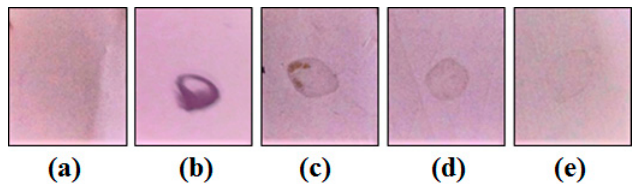
Figure 2. Dot blot assay using human anti-insulin as primary antibodies. ( a ) Tris-buffered saline; ( b ) Human recombinant insulin (2 mg/mL) incubated with human anti-insulin IgG (1:250); ( c – e ) Mo -LPI (2 mg/mL) incubated with primary antibodies diluted 1:250, 1:500 and 1:1000, respectively.